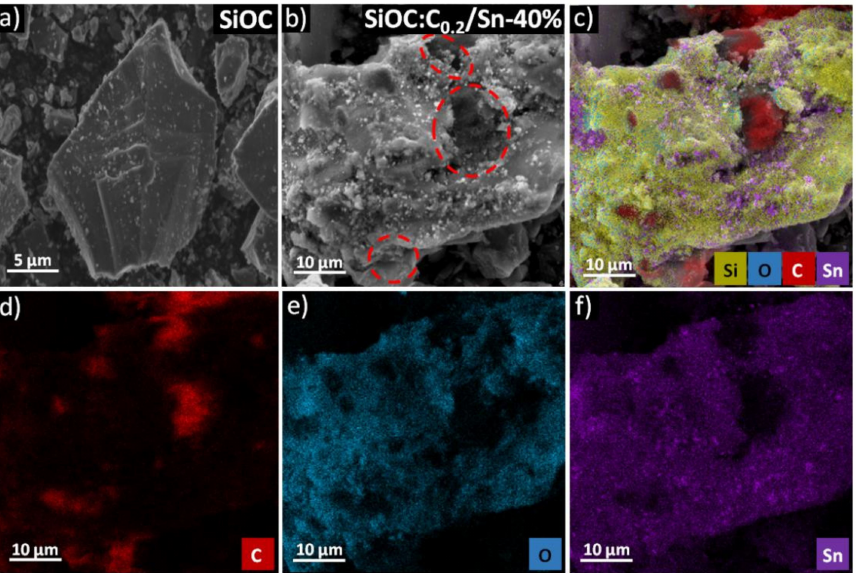
Figure 3. SEM image of ( a ) SiOC and ( b ) SiOC:C 0.2 /Sn-40% composite; ( c – f ) X-ray elemental maps of silicon, carbon, oxygen, and tin of the SiOC:C 0.2 /Sn-40% composite. A deeper insight into the microstructure of the ternary composites was provided by transmission electron microscopy. TEM images of the binary SiOC/Sn-40% and the ternary SiOC:C 0.2 /Sn-60% composite are shown in Figure 4a,b, respectively. The microstructure of SiOC/Sn-40% consists of tin nanoparticles, represented by black dots, immersed in a featureless amorphous structure of SiOC [47,48]. In comparison, the SiOC:C 0.2